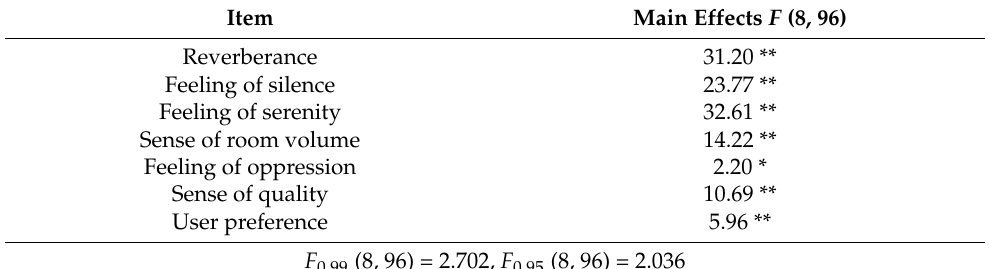
Table 8. Results of the ANOVA of the psychological scales and main effects for each evaluation item. Item